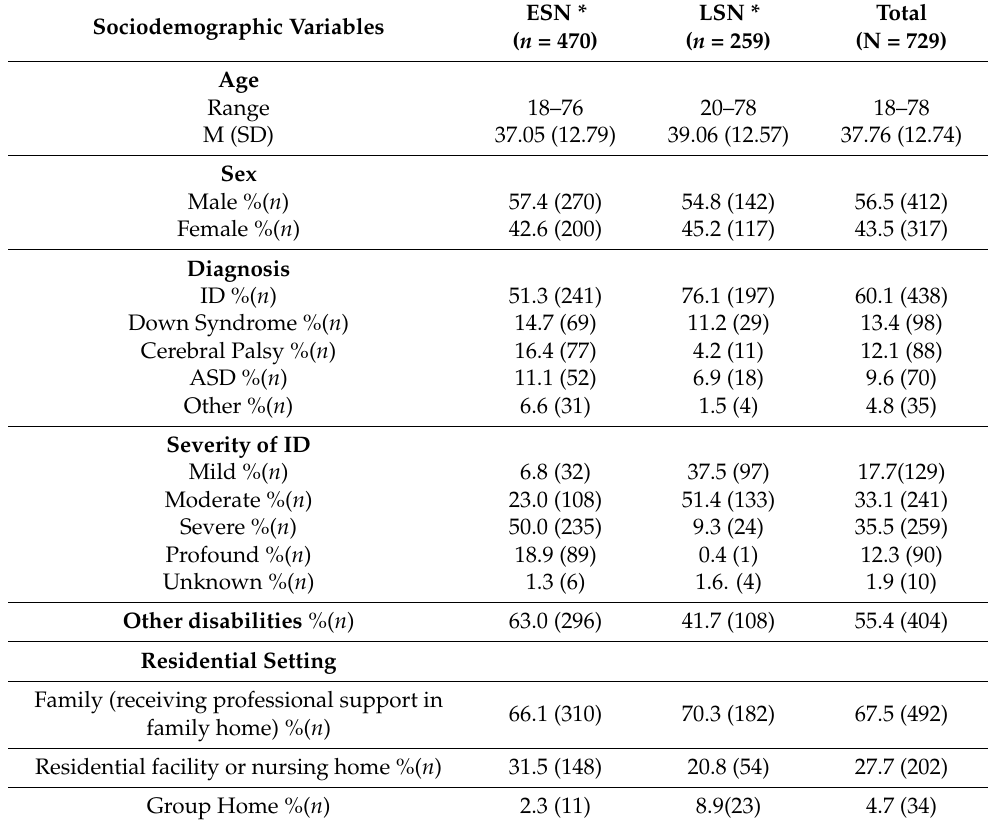
Table 1. Sociodemographic